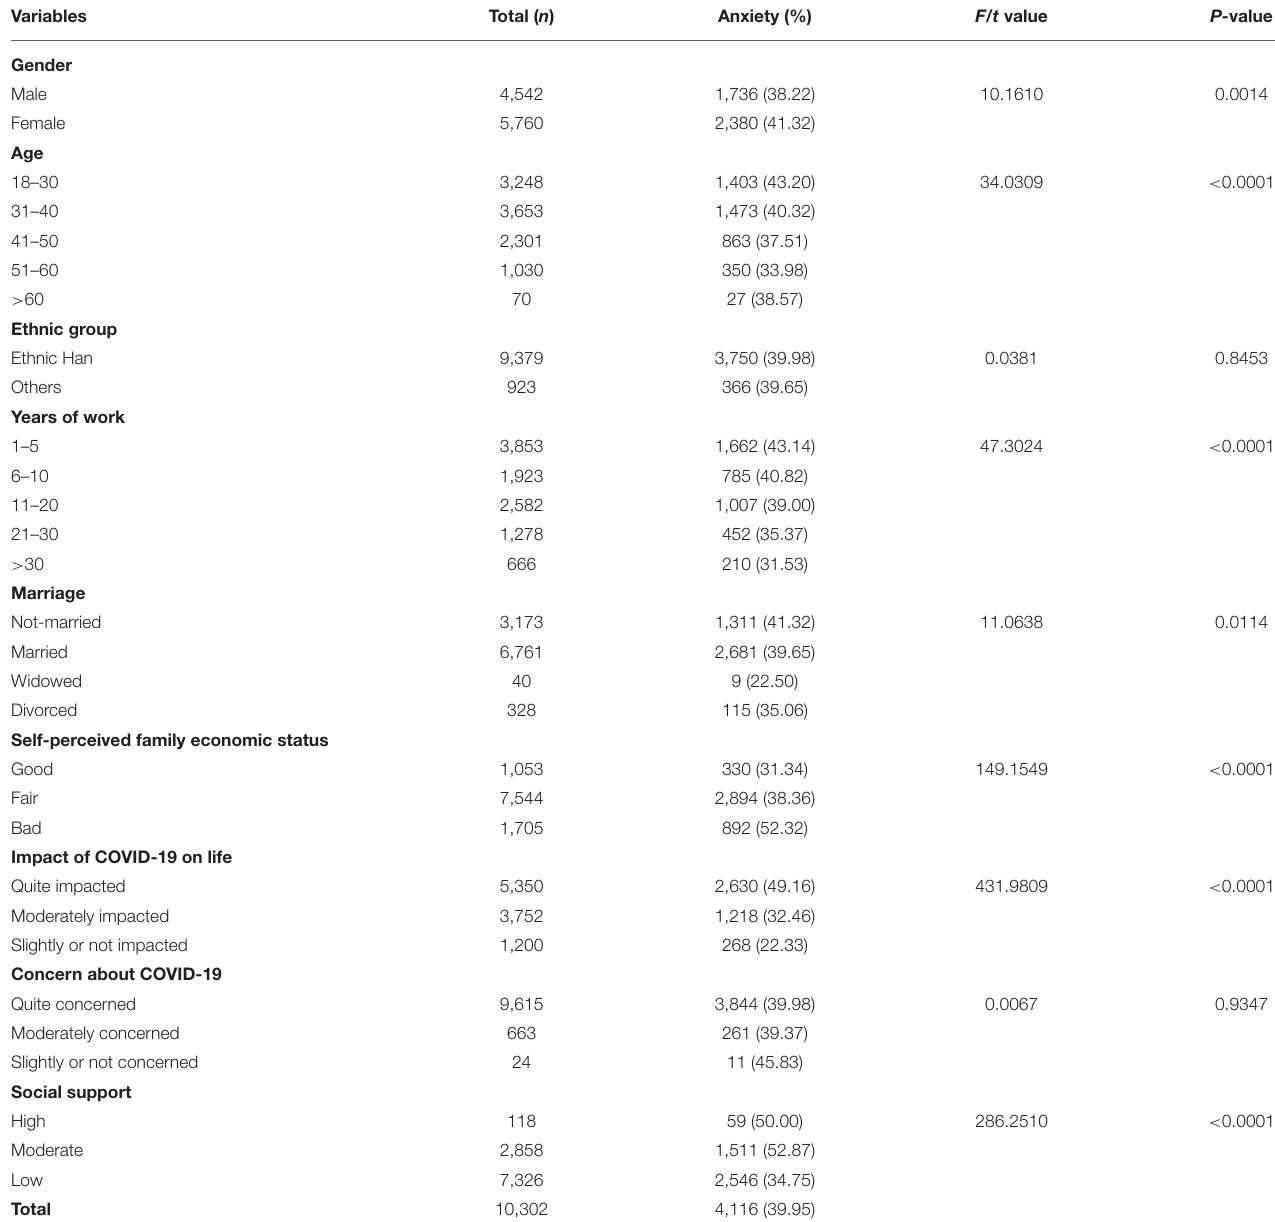
TABLE 1 | The anxiety of university teachers 1 year after COVID-19 pandemic.